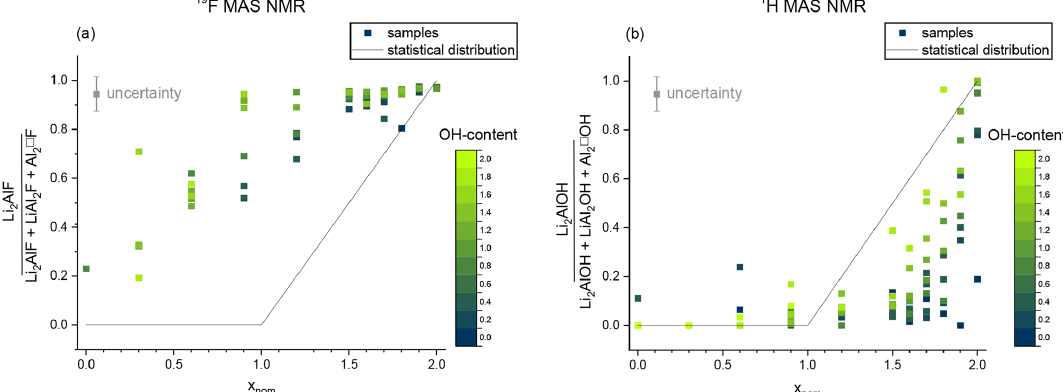
Figure 11. Non-statistical distribution of the F anion (a) and the OH anion (b) . The signal intensity of the Li 2 Al environment is plotted against the sum of signals originating from the octahedral sites (Li 2 Al, LiAl 2 , Al 2 ). The OH content is given by the blue and green colours. The black line shows the expected statistical value.